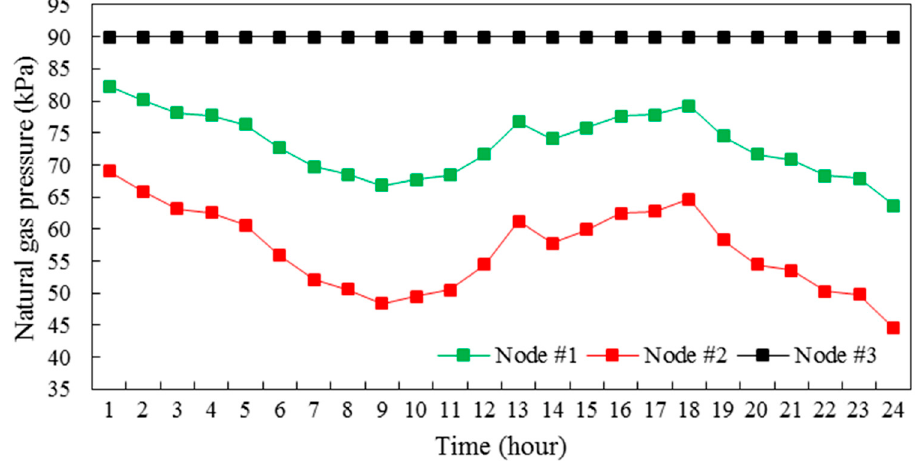
Figure 8. Change of voltage and voltage angle in the electricity system.